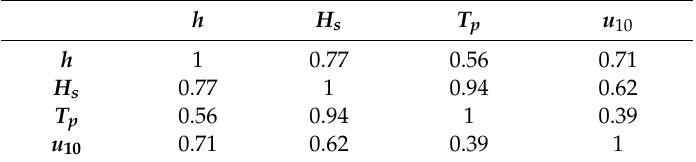
Table A4. The correlation matrix between hydraulic parameters fitted from